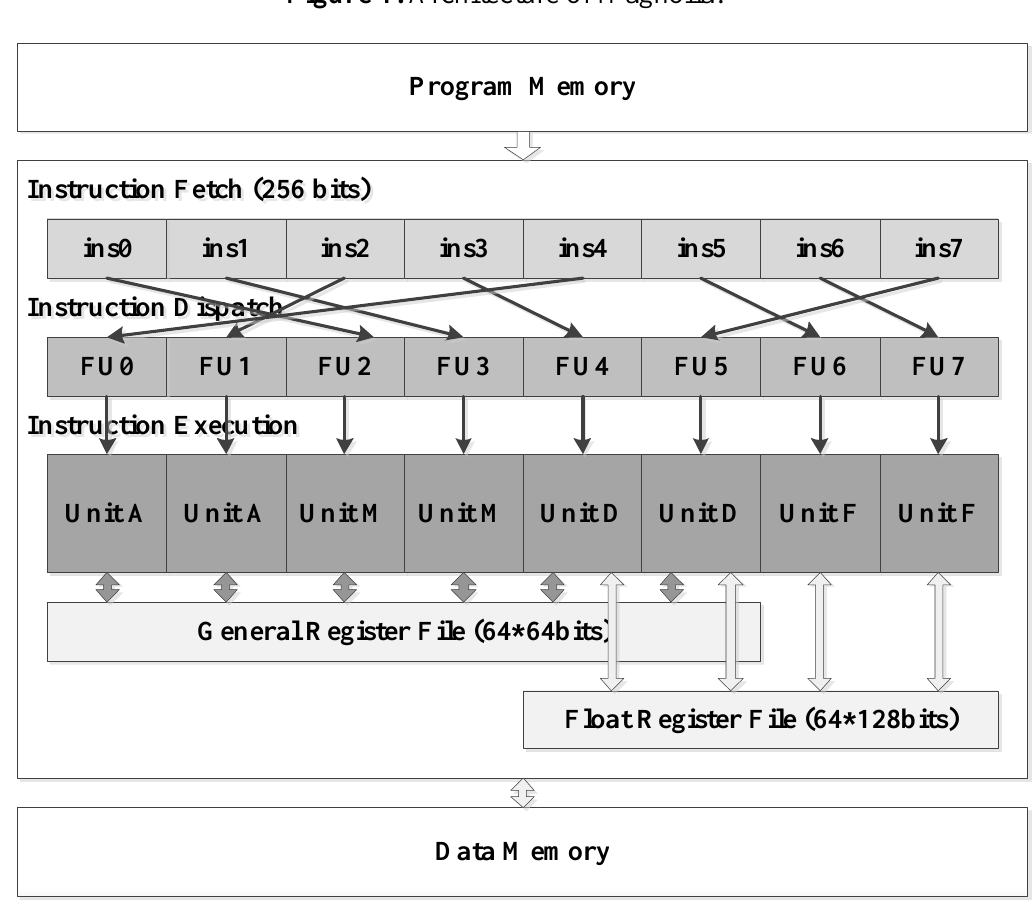
Figure 1. Architecture of